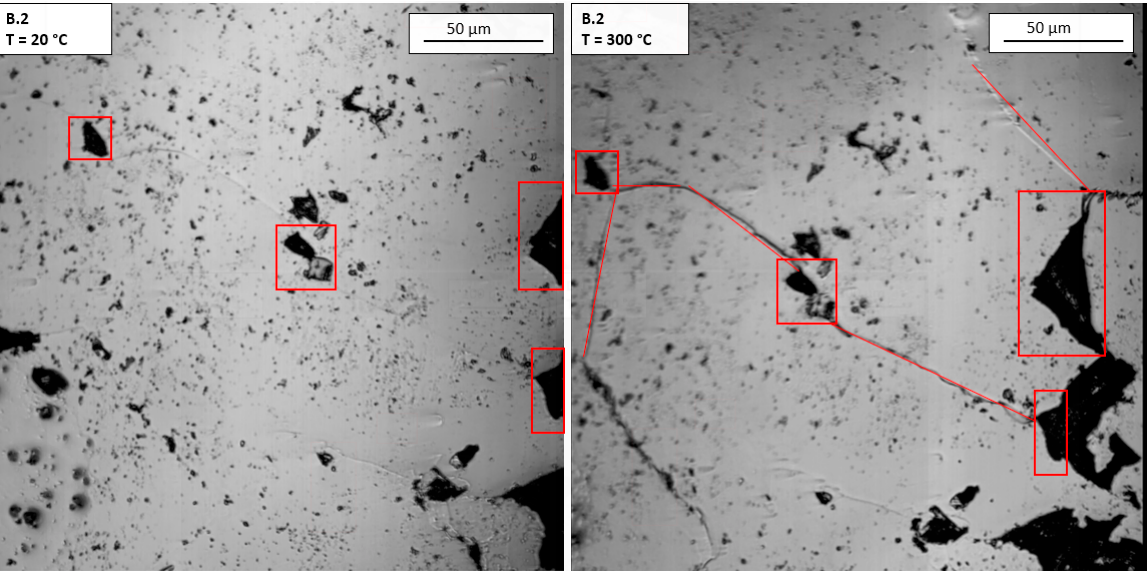
Figure 5. Images from high temperature confocal microscope (HTCM) experiment for B.2 at 20 °C and 300 °C, showing crack formation from impurity areas.